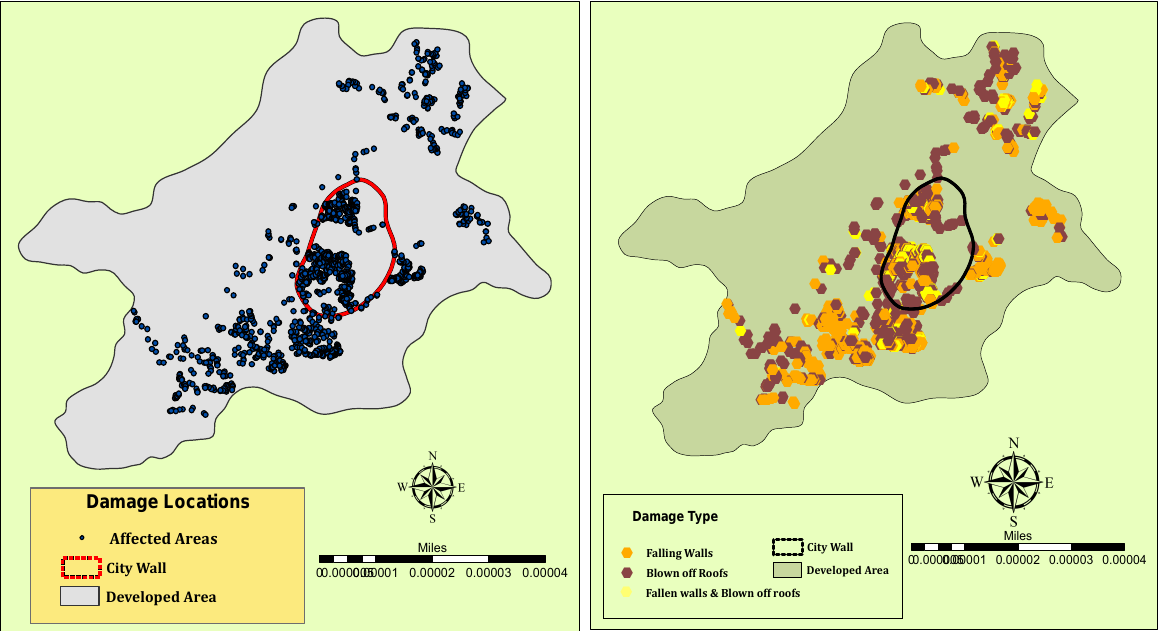
Figure 3. Damage Locations Figure 4. Damage